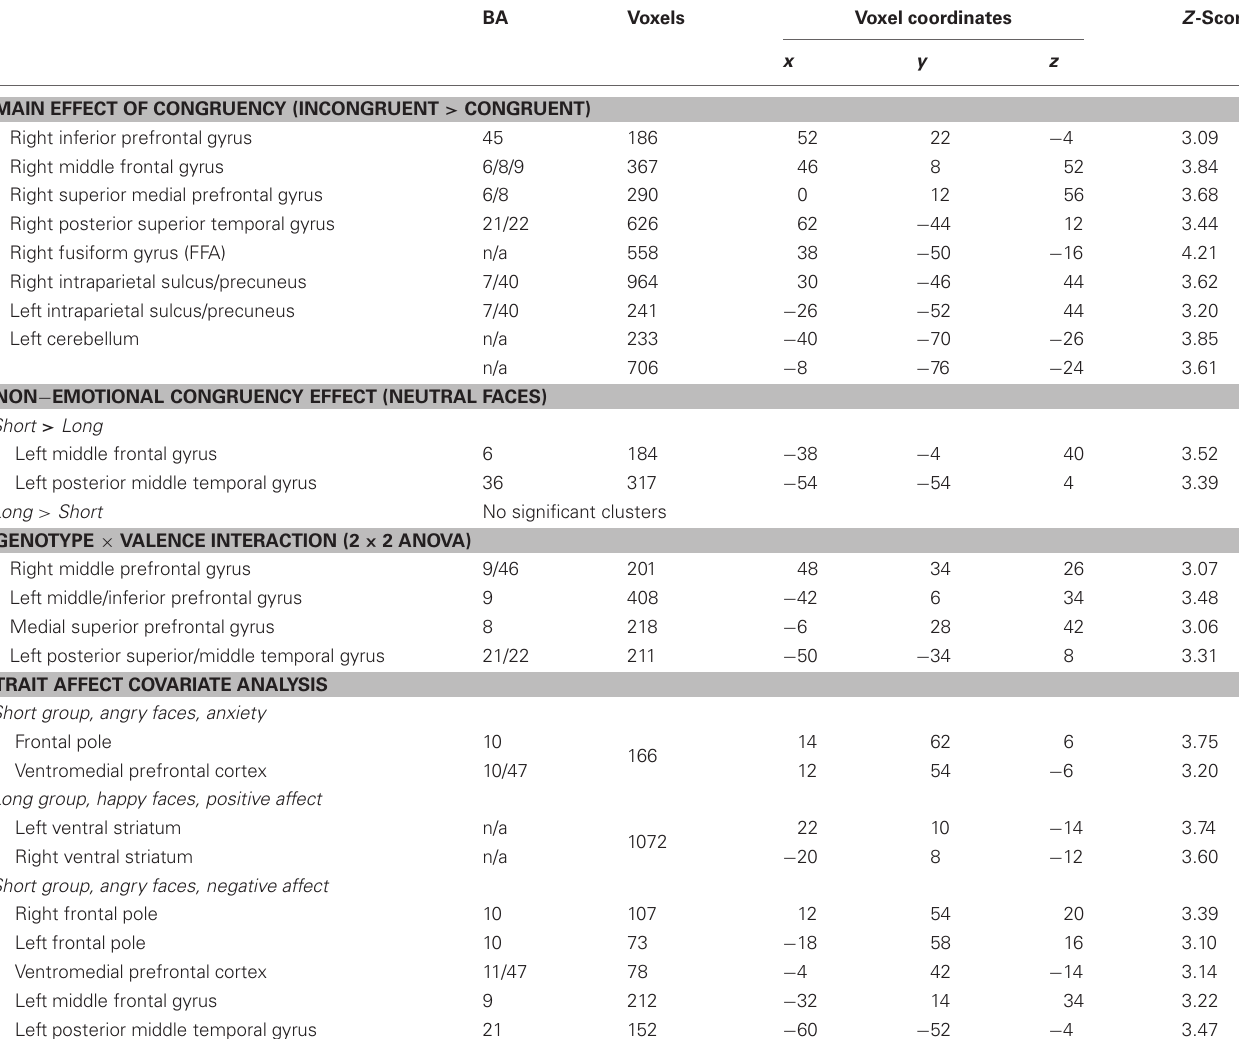
Table 4 | Regions involved in cognitive control under various emotional conditions in individual carriers of the short and long 5-HTTLPR genotype ( p = 0 . 05